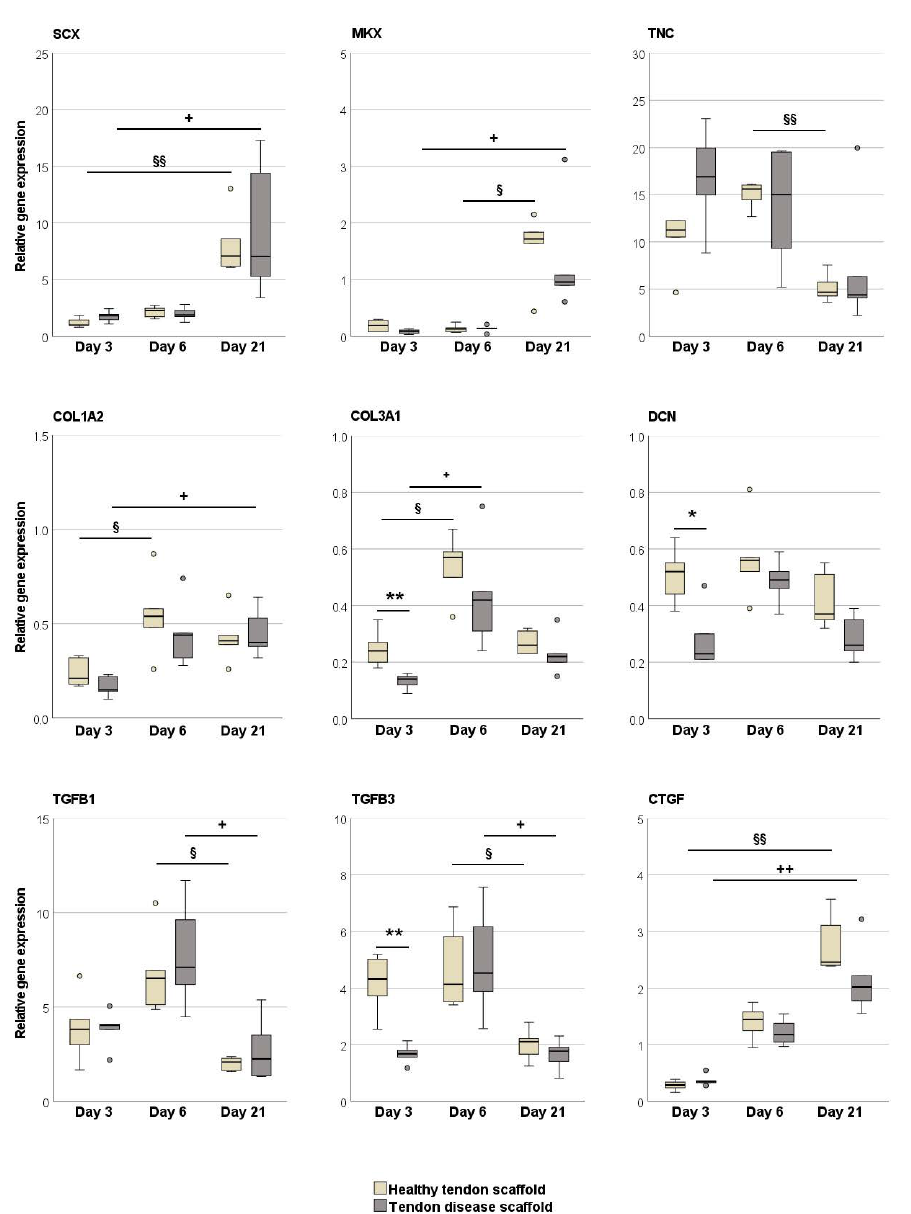
Figure 5. Relative gene expression of tendon-related genes and growth factors in MSCs seeded on healthy and diseased tendon scaffolds. Asterisks indicate significant differences between groups with p < 0.05 (*) or p < 0.01 (**). Significant differences over time are indicated by paragraph symbols for healthy tendon scaffold cultures and by plus symbols for diseased tendon scaffold cultures (§ or + for p < 0.05; §§ or ++ for p < 0.01). Data were obtained using scaffolds from n = 5 different